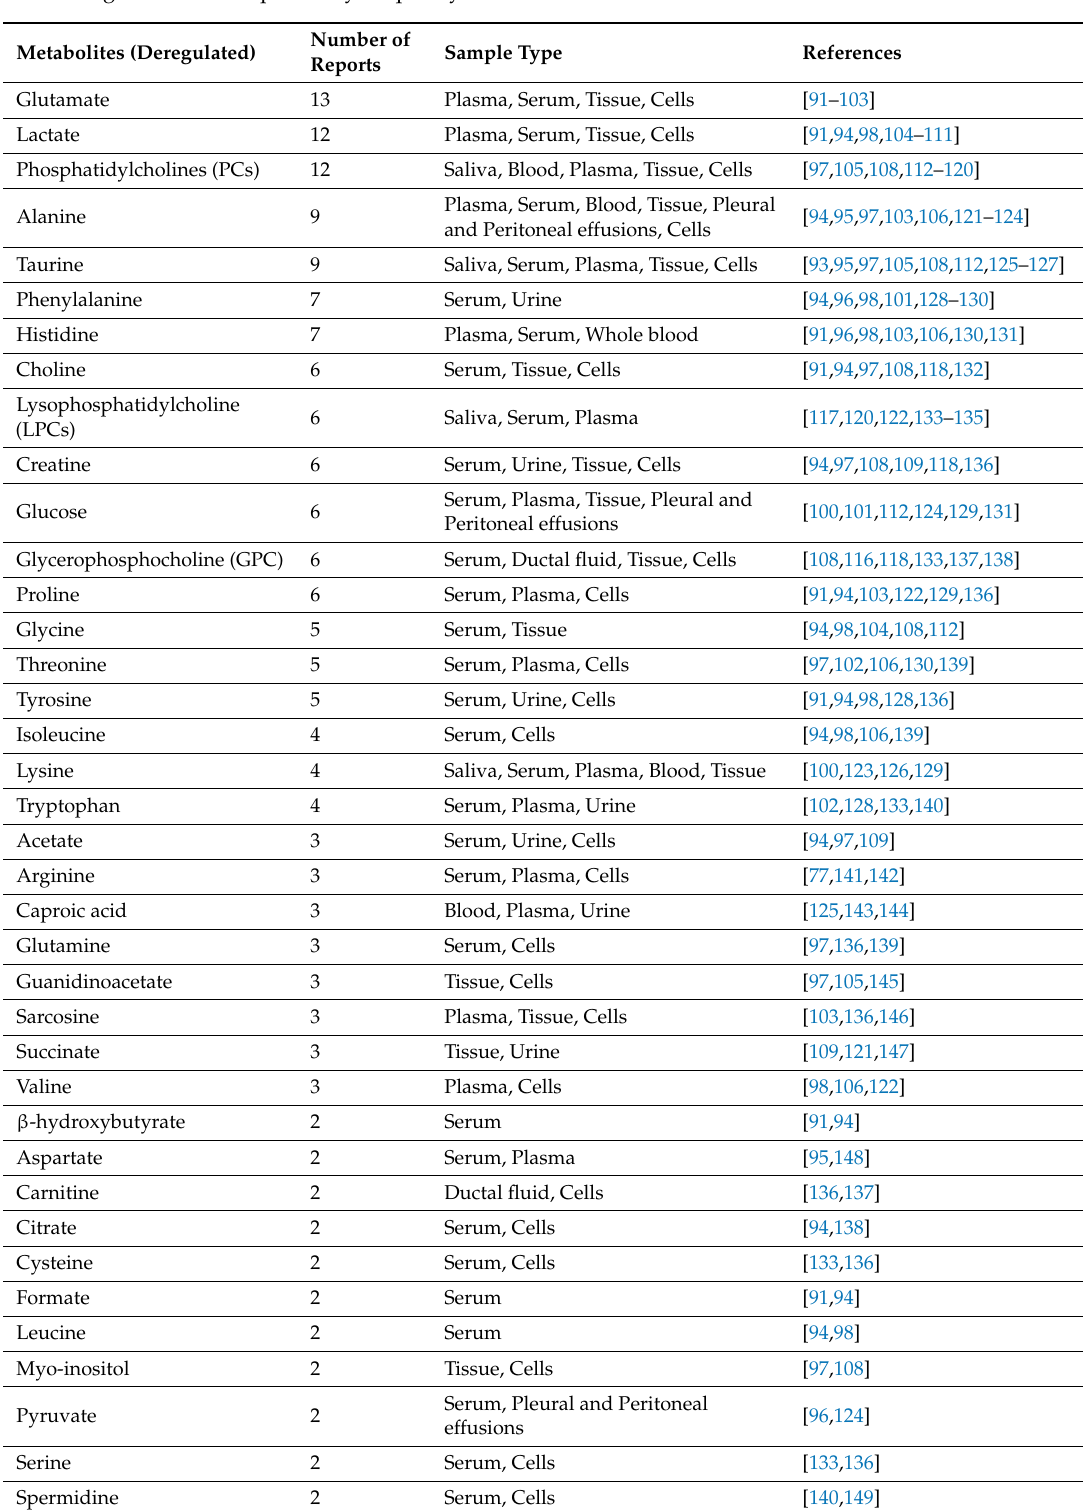
Table 3. Query https://pubmed.gov using keywords “metabolomics”, “breast cancer”, and “biomarker”. Sorting metabolites reported by